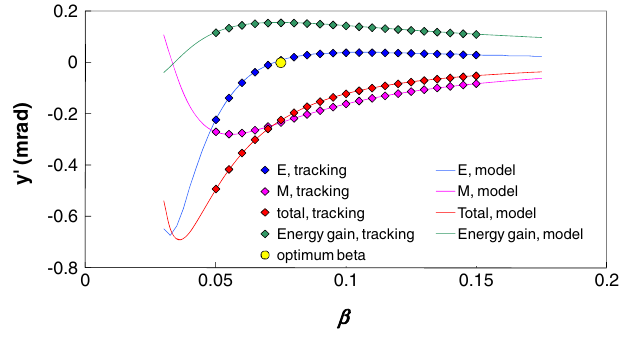
FIG. 4. Energy gain and steering curves (cid:1) y 0 ð (cid:1) Þ caused by transverse magnetic and electric fields, as well as the total steering, calculated on axis for a 106 MHz, (cid:1) ¼ 0 : 075 QWR at 1 MV = m , q=A ¼ 1 , and (cid:2) ¼ (cid:1) 30 (cid:6) , by means of the analyti- cal model (11) (lines), and numerically by means of particle tracking